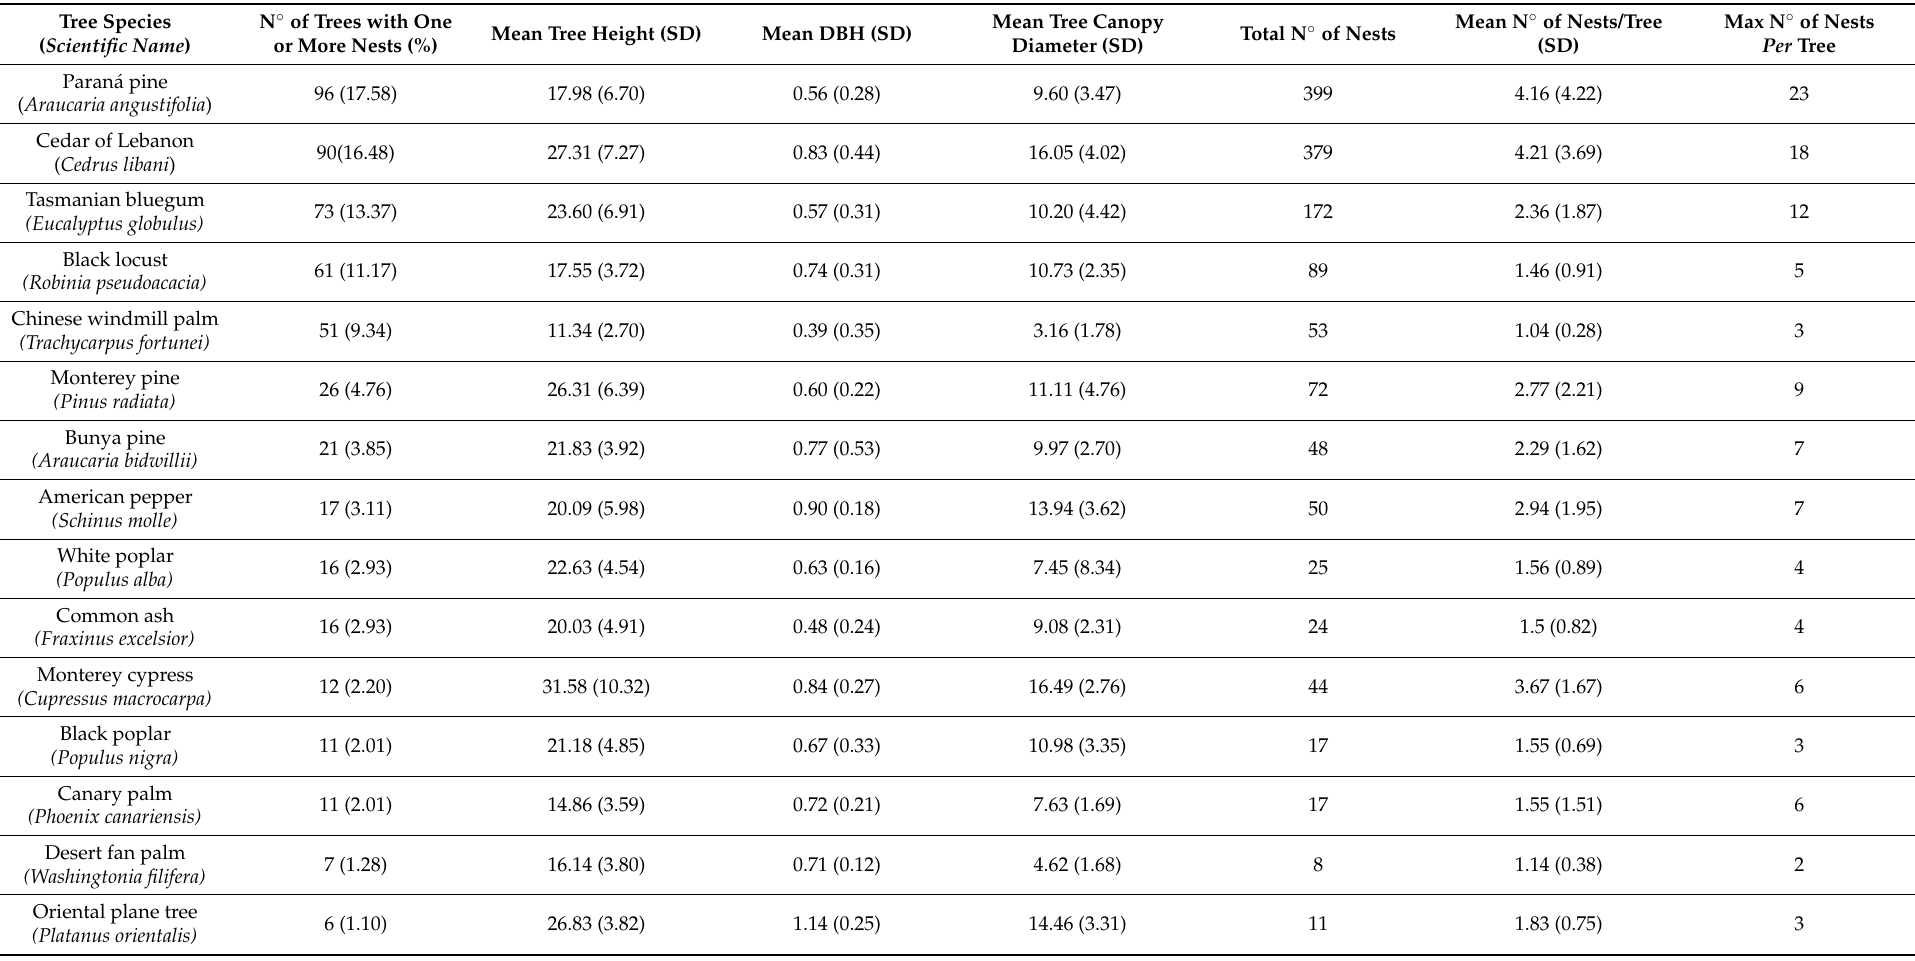
Table 1. Thirty-four tree species chosen by Monk Parakeets to construct their communal nests in the Santiago metropolis, Chile. The list is organized by frequency of Monk Parakeet nests and includes several tree and nest parameters: tree height, diameter at breast height (DBH) and canopy diameter measured in meters. * Native